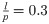
Required EOA reductions in IBNET.Our model predicts that increasing the supply duration to 23.75 hrs/day will require utilities (grey dots) to reduce their EOA by a percentage (y-axis) that depends on their initial supply duration (x-axis) and the ratio of allowed leakage increases (l) to the percent of their current NRW that is leakage (p). We plot each utility under scenarios i) and ii) (i.e., a) lp=0.3 and b) lp=0.02). For initial supply durations within a 1-hour span (e.g., 4.5-5.5 hrs/day), the 5th (red/upper line), 50th (i.e., median, green/middle line), and 95th (blue/lower line) percentiles are smoothed into the displayed curves.